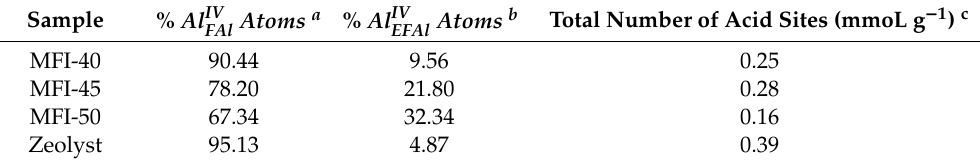
Table 2. Types of Aluminum and total number of acid sites for studied samples.